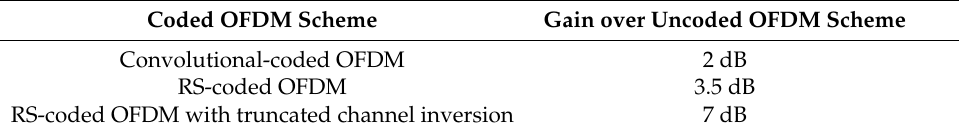
Table 2. E b / N 0 gain for different coded OFDM schemes